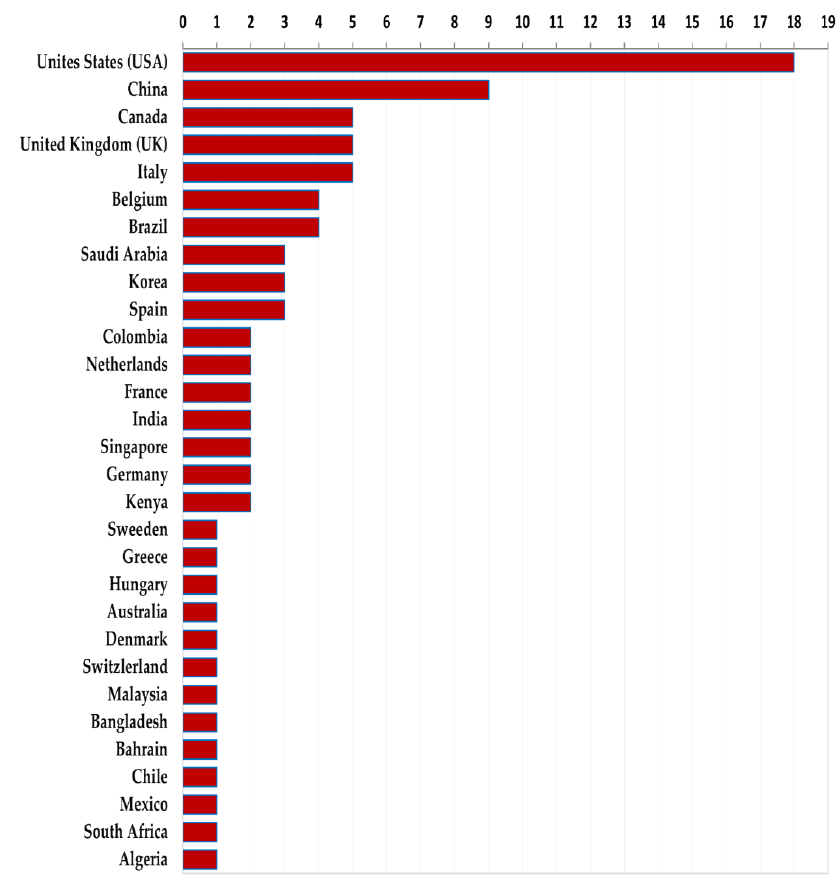
Figure 5. Number of studies per country of the research.